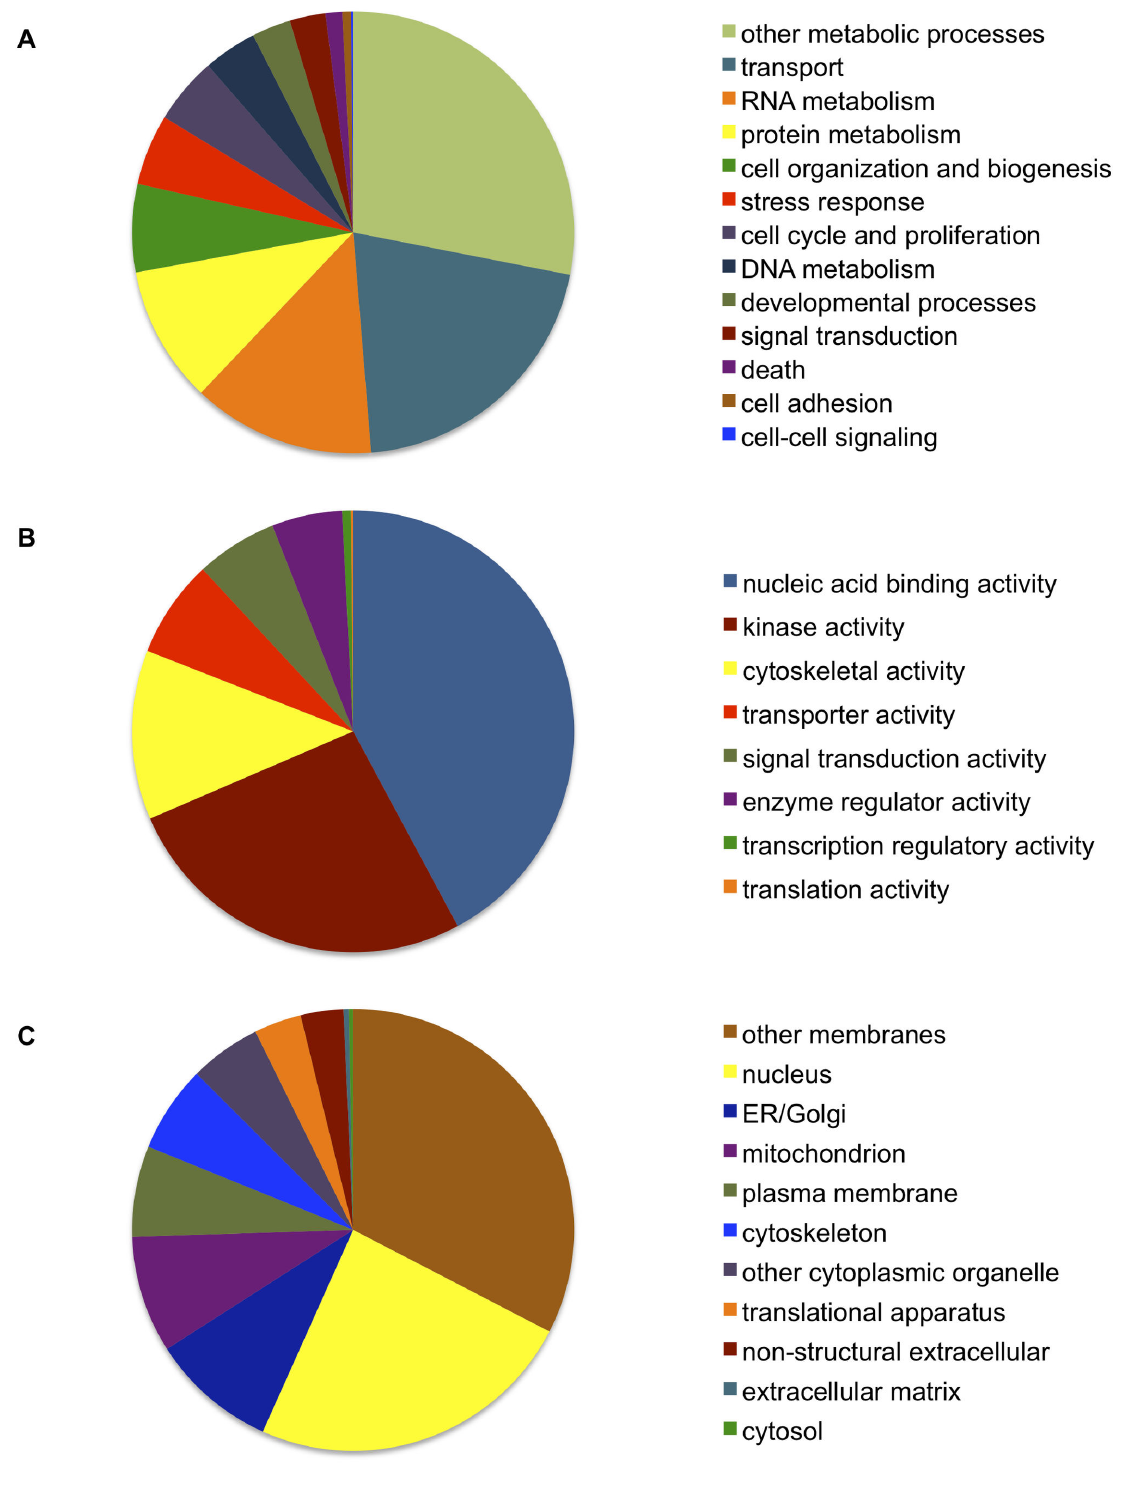
Figure 1. Classification of annotated QPX contigs based on Gene Ontology. Representation of (a) biological processes, (b) molecular function, and (c) cellular components from Gene Ontology Slim terms based on Swiss-Prot gene annotations. The gene ontology categories ‘other biological processes functions’ (a), ‘other molecular functions’ (b), and ‘other cellular components’ (c) were excluded from these graphs. doi: 10.1371/journal.pone.0074196.g001 PLOS ONE |